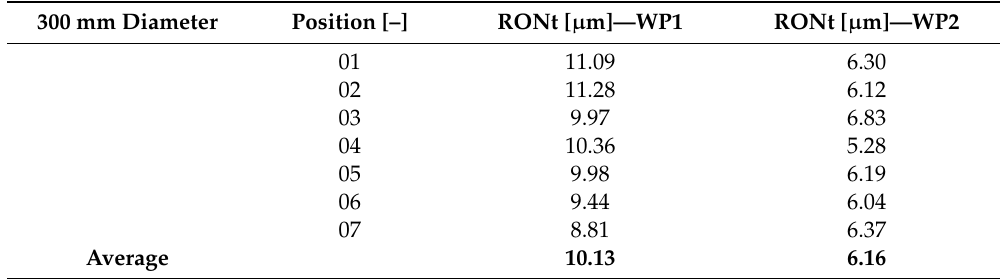
Table 11. RONt results [µm]—300 mm diameter.